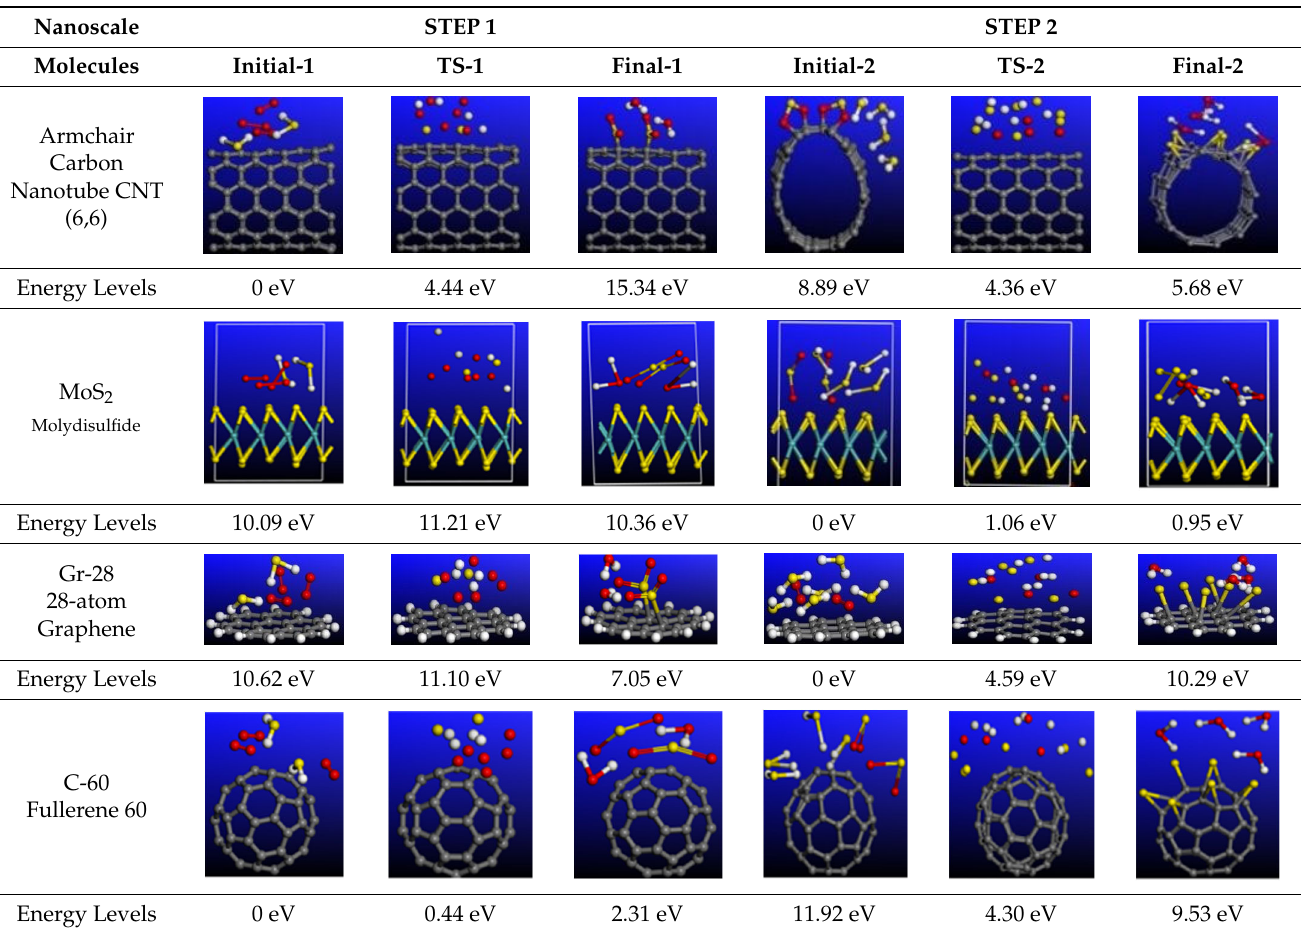
Hydrogen 2023 , 4 , FOR PEER REVIEW 5 Table 4. Respective rows of geometrical optimized nanoscale molecules catalyzing the two ‐ step Table 4. Respective rows of geometrical optimized nanoscale molecules catalyzing the two ‐ step Table 4. Respective rows of geometrical optimized nanoscale molecules catalyzing the two ‐ step Table 4. Respective rows of geometrical optimized nanoscale molecules catalyzing the two ‐ step Table 4. Respective rows of geometrical optimized nanoscale molecules catalyzing the two ‐ step Table 4. Respective rows of geometrical optimized nanoscale molecules catalyzing the two ‐ step Table 4. Respective rows of geometrical optimized nanoscale molecules catalyzing the two ‐ step Table 4. Respective rows of geometrical optimized nanoscale molecules catalyzing the two ‐ step Table 4. Respective rows of geometrical optimized nanoscale molecules catalyzing the two ‐ step Table 4. Respective rows of geometrical optimized nanoscale molecules catalyzing the two ‐ step Table 4. Respective rows of geometrical optimized nanoscale molecules catalyzing the two ‐ step Table 4. Respective rows of geometrical optimized nanoscale molecules catalyzing the two ‐ step desulfurization reactions. The relative initial, transition, and final state energies are reported in elec ‐ desulfurization reactions. The relative initial, transition, and final state energies are reported in elec ‐ desulfurization reactions. The relative initial, transition, and final state energies are reported in elec ‐ desulfurization reactions. The relative initial, transition, and final state energies are reported in elec ‐ desulfurization reactions. The relative initial, transition, and final state energies are reported in elec ‐ desulfurization reactions. The relative initial, transition, and final state energies are reported in elec ‐ Table 4. Respective rows of geometrical optimized nanoscale molecules catalyzing the two ‐ step Table 4. Respective rows of geometrical optimized nanoscale molecules catalyzing the two ‐ step Table 4. Respective rows of geometrical optimized nanoscale molecules catalyzing the two ‐ step Table 4. Respective rows of geometrical optimized nanoscale molecules catalyzing the two ‐ step Table 4. Respective rows of geometrical optimized nanoscale molecules catalyzing the two ‐ step desulfurization reactions. The relative initial, transition, and final state energies are reported in elec ‐ desulfurization reactions. The relative initial, transition, and final state energies are reported in elec ‐ Table 4. Respective rows of geometrical optimized nanoscale molecules catalyzing the two ‐ step desulfurization reactions. The relative initial, transition, and final state energies are reported in elec ‐ desulfurization reactions. The relative initial, transition, and final state energies are reported in elec ‐ desulfurization reactions. The relative initial, transition, and final state energies are reported in elec ‐ desulfurization reactions. The relative initial, transition, and final state energies are reported in elec ‐ Table 4. Respective rows of geometrical optimized nanoscale molecules catalyzing the two-step tro ‐ Volts (eV) for the armchair carbon nanotube CNT (6,6), molydisulfide MoS 2 , 28 ‐ atom graphene tro ‐ Volts (eV) for the armchair carbon nanotube CNT (6,6), molydisulfide MoS 2 , 28 ‐ atom graphene tro ‐ Volts (eV) for the armchair carbon nanotube CNT (6,6), molydisulfide MoS 2 , 28 ‐ atom graphene tro ‐ Volts (eV) for the armchair carbon nanotube CNT (6,6), molydisulfide MoS 2 , 28 ‐ atom graphene tro ‐ Volts (eV) for the armchair carbon nanotube CNT (6,6), molydisulfide MoS 2 , 28 ‐ atom graphene tro ‐ Volts (eV) for the armchair carbon nanotube CNT (6,6), molydisulfide MoS 2 , 28 ‐ atom graphene desulfurization reactions. The relative initial, transition, and final state energies are reported in elec ‐ desulfurization reactions. The relative initial, transition, and final state energies are reported in elec ‐ desulfurization reactions. The relative initial, transition, and final state energies are reported in elec ‐ desulfurization reactions. The relative initial, transition, and final state energies are reported in elec ‐ desulfurization reactions. The relative initial, transition, and final state energies are reported in elec ‐ tro ‐ Volts (eV) for the armchair carbon nanotube CNT (6,6), molydisulfide MoS 2 , 28 ‐ atom graphene tro ‐ Volts (eV) for the armchair carbon nanotube CNT (6,6), molydisulfide MoS 2 , 28 ‐ atom graphene desulfurization reactions. The relative initial, transition, and final state energies are reported in elec ‐ Table 4. Respective rows of geometrical optimized nanoscale molecules catalyzing the two ‐ step Table 4. Respective rows of geometrical optimized nanoscale molecules catalyzing the two ‐ step Table 4. Respective rows of geometrical optimized nanoscale molecules catalyzing the two ‐ step Table 4. Respective rows of geometrical optimized nanoscale molecules catalyzing the two ‐ step Table 4. Respective rows of geometrical optimized nanoscale molecules catalyzing the two ‐ step tro ‐ Volts (eV) for the armchair carbon nanotube CNT (6,6), molydisulfide MoS 2 , 28 ‐ atom graphene Table 4. Respective rows of geometrical optimized nanoscale molecules catalyzing the two ‐ step tro ‐ Volts (eV) for the armchair carbon nanotube CNT (6,6), molydisulfide MoS 2 , 28 ‐ atom graphene tro ‐ Volts (eV) for the armchair carbon nanotube CNT (6,6), molydisulfide MoS 2 , 28 ‐ atom graphene tro ‐ Volts (eV) for the armchair carbon nanotube CNT (6,6), molydisulfide MoS 2 , 28 ‐ atom graphene Gr ‐ 28, and fullerene C ‐ 60 nanoscale catalysts. The sulfur, carbon, oxygen, and hydrogen atoms are desulfurization reactions. The relative initial, transition, and final state energies are reported in Gr ‐ 28, and fullerene C ‐ 60 nanoscale catalysts. The sulfur, carbon, oxygen, and hydrogen atoms are Gr ‐ 28, and fullerene C ‐ 60 nanoscale catalysts. The sulfur, carbon, oxygen, and hydrogen atoms are Gr ‐ 28, and fullerene C ‐ 60 nanoscale catalysts. The sulfur, carbon, oxygen, and hydrogen atoms are Gr ‐ 28, and fullerene C ‐ 60 nanoscale catalysts. The sulfur, carbon, oxygen, and hydrogen atoms are Gr ‐ 28, and fullerene C ‐ 60 nanoscale catalysts. The sulfur, carbon, oxygen, and hydrogen atoms are tro ‐ Volts (eV) for the armchair carbon nanotube CNT (6,6), molydisulfide MoS 2 , 28 ‐ atom graphene tro ‐ Volts (eV) for the armchair carbon nanotube CNT (6,6), molydisulfide MoS 2 , 28 ‐ atom graphene tro ‐ Volts (eV) for the armchair carbon nanotube CNT (6,6), molydisulfide MoS 2 , 28 ‐ atom graphene tro ‐ Volts (eV) for the armchair carbon nanotube CNT (6,6), molydisulfide MoS 2 , 28 ‐ atom graphene tro ‐ Volts (eV) for the armchair carbon nanotube CNT (6,6), molydisulfide MoS 2 , 28 ‐ atom graphene Gr ‐ 28, and fullerene C ‐ 60 nanoscale catalysts. The sulfur, carbon, oxygen, and hydrogen atoms are Gr ‐ 28, and fullerene C ‐ 60 nanoscale catalysts. The sulfur, carbon, oxygen, and hydrogen atoms are tro ‐ Volts (eV) for the armchair carbon nanotube CNT (6,6), molydisulfide MoS 2 , 28 ‐ atom graphene desulfurization reactions. The relative initial, transition, and final state energies are reported in elec ‐ desulfurization reactions. The relative initial, transition, and final state energies are reported in elec ‐ desulfurization reactions. The relative initial, transition, and final state energies are reported in elec ‐ desulfurization reactions. The relative initial, transition, and final state energies are reported in elec ‐ desulfurization reactions. The relative initial, transition, and final state energies are reported in elec ‐ Gr ‐ 28, and fullerene C ‐ 60 nanoscale catalysts. The sulfur, carbon, oxygen, and hydrogen atoms are desulfurization reactions. The relative initial, transition, and final state energies are reported in elec ‐ Gr ‐ 28, and fullerene C ‐ 60 nanoscale catalysts. The sulfur, carbon, oxygen, and hydrogen atoms are Gr ‐ 28, and fullerene C ‐ 60 nanoscale catalysts. The sulfur, carbon, oxygen, and hydrogen atoms are Gr ‐ 28, and fullerene C ‐ 60 nanoscale catalysts. The sulfur, carbon, oxygen, and hydrogen atoms are represented by the yellow, gray, red, and white spheres, respectively. represented by the yellow, gray, red, and white spheres, respectively. represented by the yellow, gray, red, and white spheres, respectively. represented by the yellow, gray, red, and white spheres, respectively. represented by the yellow, gray, red, and white spheres, respectively. represented by the yellow, gray, red, and white spheres, respectively. electro-Volts (eV) for the armchair carbon nanotube CNT (6,6), molydisulfide MoS 2 , 28-atom graphene Gr ‐ 28, and fullerene C ‐ 60 nanoscale catalysts. The sulfur, carbon, oxygen, and hydrogen atoms are Gr ‐ 28, and fullerene C ‐ 60 nanoscale catalysts. The sulfur, carbon, oxygen, and hydrogen atoms are Gr ‐ 28, and fullerene C ‐ 60 nanoscale catalysts. The sulfur, carbon, oxygen, and hydrogen atoms are Gr ‐ 28, and fullerene C ‐ 60 nanoscale catalysts. The sulfur, carbon, oxygen, and hydrogen atoms are Gr ‐ 28, and fullerene C ‐ 60 nanoscale catalysts. The sulfur, carbon, oxygen, and hydrogen atoms are represented by the yellow, gray, red, and white spheres, respectively. represented by the yellow, gray, red, and white spheres, Gr ‐ 28, and fullerene C ‐ 60 nanoscale catalysts. The sulfur, carbon, oxygen, and hydrogen atoms are tro ‐ Volts (eV) for the armchair carbon nanotube CNT (6,6), molydisulfide MoS 2 , 28 ‐ atom graphene tro ‐ Volts (eV) for the armchair carbon nanotube CNT (6,6), molydisulfide MoS 2 , 28 ‐ atom graphene tro ‐ Volts (eV) for the armchair carbon nanotube CNT (6,6), molydisulfide MoS 2 , 28 ‐ atom graphene tro ‐ Volts (eV) for the armchair carbon nanotube CNT (6,6), molydisulfide MoS 2 , 28 ‐ atom graphene tro ‐ Volts (eV) for the armchair carbon nanotube CNT (6,6), molydisulfide MoS 2 , 28 ‐ atom graphene represented by the yellow, gray, red, and white spheres, respectively. tro ‐ Volts (eV) for the armchair carbon nanotube CNT (6,6), molydisulfide MoS 2 , 28 ‐ atom graphene represented by the yellow, gray, red, and white spheres, respectively. represented by the yellow, gray, red, and white spheres, respectively. represented by the yellow, gray, red, and white spheres, respectively. Gr-28, and fullerene C-60 nanoscale catalysts. The sulfur, carbon, oxygen, and hydrogen atoms are represented by the yellow, gray, red, and white spheres, respectively. represented by the yellow, gray, red, and white spheres, respectively. represented by the yellow, gray, red, and white spheres, respectively. represented by the yellow, gray, red, and white spheres, respectively. represented by the yellow, gray, red, and white spheres, respectively. represented by the yellow, gray, red, and white spheres, respectively. Gr ‐ 28, and fullerene C ‐ 60 nanoscale catalysts. The sulfur, carbon, oxygen, and hydrogen atoms are Gr ‐ 28, and fullerene C ‐ 60 nanoscale catalysts. The sulfur, carbon, oxygen, and hydrogen atoms are Gr ‐ 28, and fullerene C ‐ 60 nanoscale catalysts. The sulfur, carbon, oxygen, and hydrogen atoms are Gr ‐ 28, and fullerene C ‐ 60 nanoscale catalysts. The sulfur, carbon, oxygen, and hydrogen atoms are Gr ‐ 28, and fullerene C ‐ 60 nanoscale catalysts. The sulfur, carbon, oxygen, and hydrogen atoms are Gr ‐ 28, and fullerene C ‐ 60 nanoscale catalysts. The sulfur, carbon, oxygen, and hydrogen atoms are represented by the yellow, gray, red, and white spheres, respectively. represented by the yellow, gray, red, and white spheres, respectively. represented by the yellow, gray, red, and white spheres, respectively. represented by the yellow, gray, red, and white spheres, respectively. represented by the yellow, gray, red, and white spheres, respectively. represented by the yellow, gray, red, and white spheres, respectively. represented by the yellow, gray, red, and white spheres, respectively.